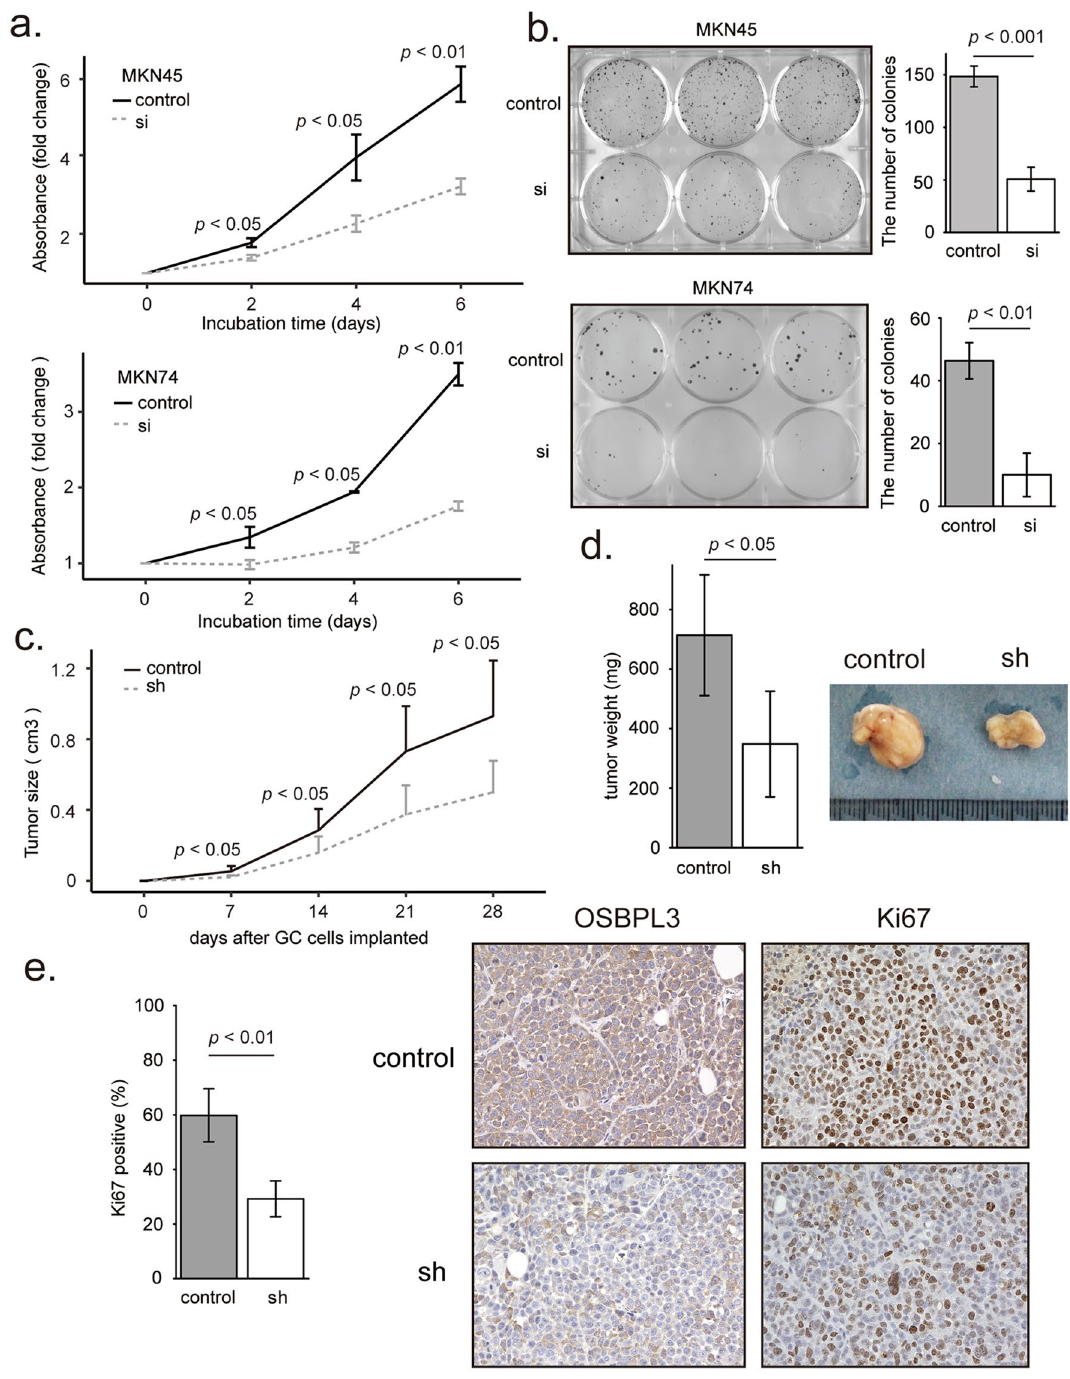
Figure 2. Effect of OSBPL3 on cell proliferation and tumor growth in GC. ( a ) MTT assays in GC cells (MKN45 and MKN74) transfected with OSBPL3- specific siRNAs. si: siRNA targeting OSBPL3 . N = 9, error bars represent the mean ± SD. Student’s t -test. ( b ) Colony formation assays in GC cells (MKN45 and MKN74) transfected with OSBPL3- specific siRNAs. si: siRNA targeting OSBPL3 . N = 3, error bars represent the mean ± SD. Student’s t -test. ( c ) Growth curve of tumors derived from 5.0 × 10 6 GC cells (transfected with OSBPL3- specific shRNA or control-shRNA) injected into xenograft mice. sh: shRNA targeting OSBPL3 . N = 7, error bars represent the mean + SD. Student’s t -test. ( d ) The weights of tumors derived from 5.0 × 10 6 GC cells ((transfected with OSBPL3- specific shRNA or control-shRNA) injected into xenograft mice and representative images of the tumors. sh: shRNA targeting OSBPL3 . N = 7, error bars represent the mean ± SD. Student’s t -test. ( e ) The percentage of Ki67-positive cells in tumors derived from 5.0 × 10 6 GC cells ((transfected with OSBPL3- specific shRNA or control-shRNA) injected into xenograft mice (left panel). N = 7, error bars represent the mean ± SD. Immunohistochemical analyses of OSBPL3 and Ki67 in a representative sample from xenograft mice (right panel). sh: shRNA targeting OSBPL3 . Student’s t